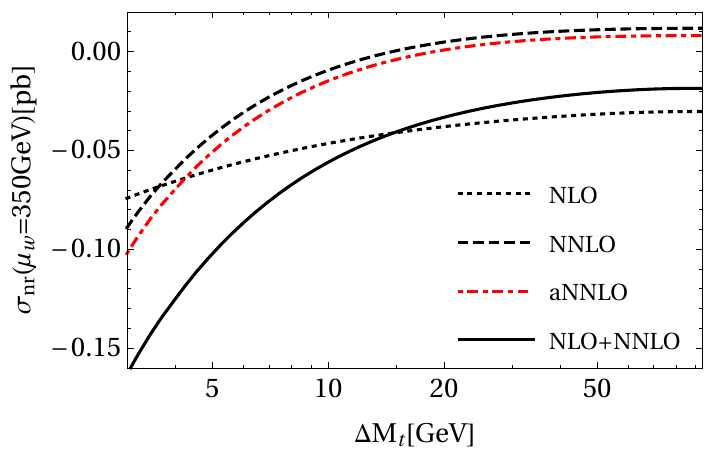
Figure 14 . The dependence of the non-resonant contribution to the cross section on the invariant mass cut (2.14). The dotted line shows the result at NLO and the dashed line the NNLO correction (without the NLO terms). The sum of both is drawn as a solid line. The red dot-dashed line denotes the approximate NNLO result (without the NLO terms) from [27]. The full cross section corresponds to (cid:1) M t = m t m W . (cid:0)